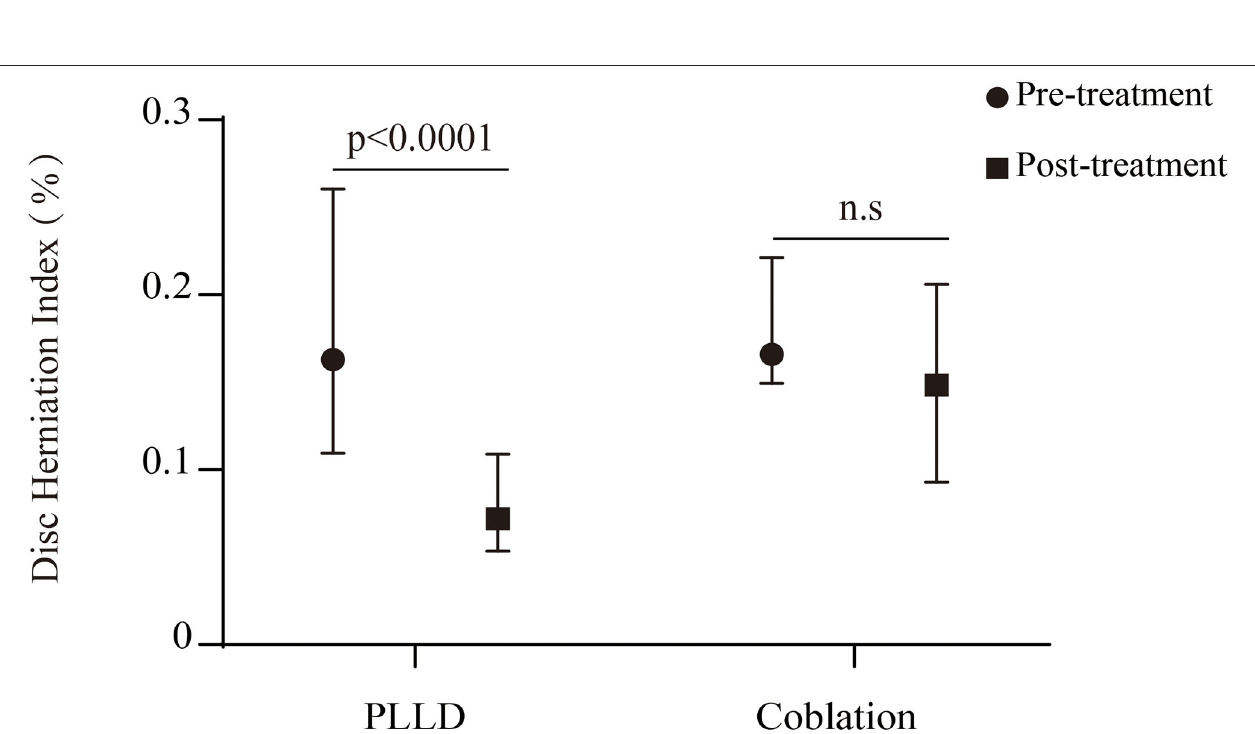
FIGURE 5 | Radiological changes of disc herniation 6 months after therapy. n.s = the exact value is 0.1510.